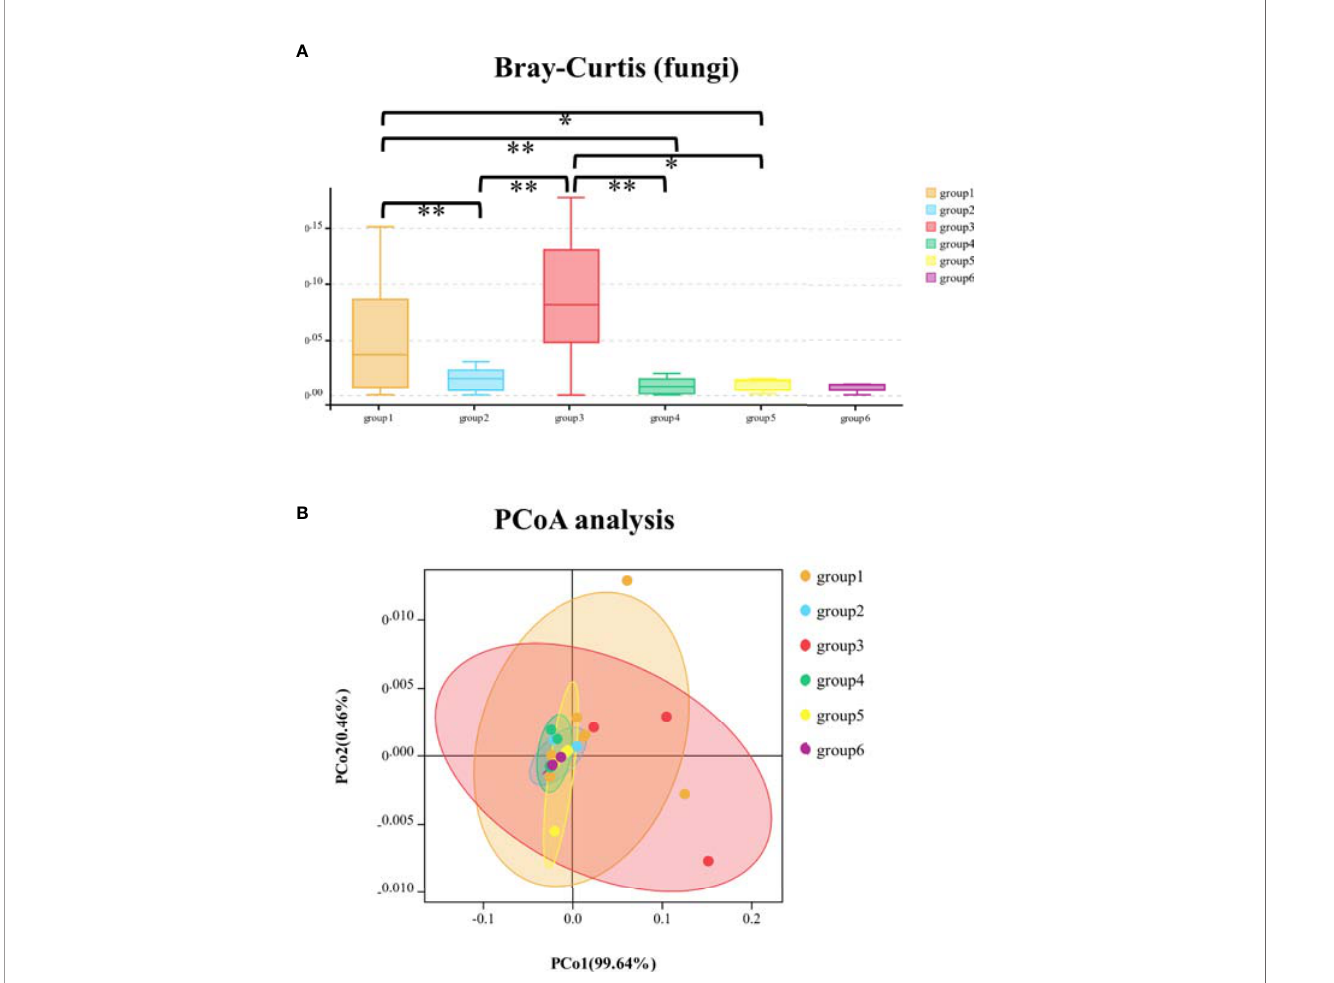
FIGURE 3 | The comparison of Bray – Curtis distance of fungal community among six groups at phylum level (A) ; principal co-ordinates analysis (PCoA) of fungal community among the six groups of samples (B) . *signi fi cant at p < 0.05, **signi fi cant at p <